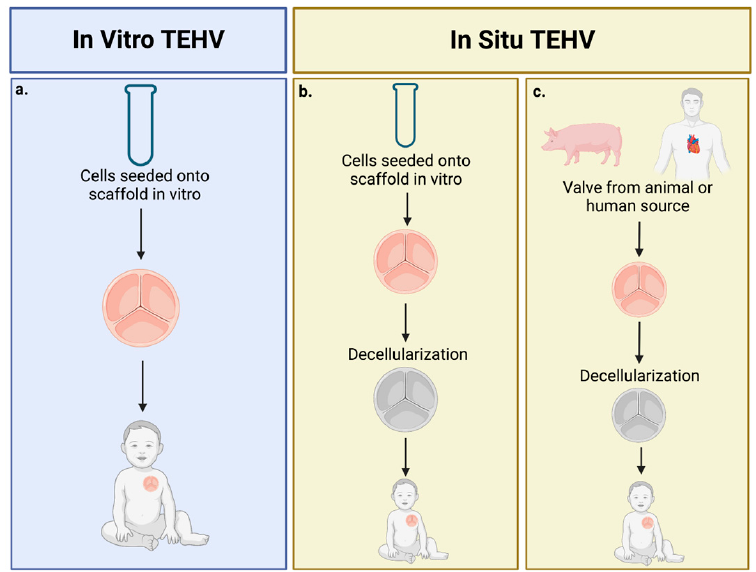
Figure 1. Overview of design methods for tissue engineering heart valves. ( a ) In vitro TEHV involves seeding cells on the scaffold in vitro, then delivering them to the patient. ( b ) In situ engineering using a decellularized in vitro designed valve. ( c ) In situ TEHV using a decellularized xenograft or allograft. Created with BioRender.com (accessed on 26 March 2023).